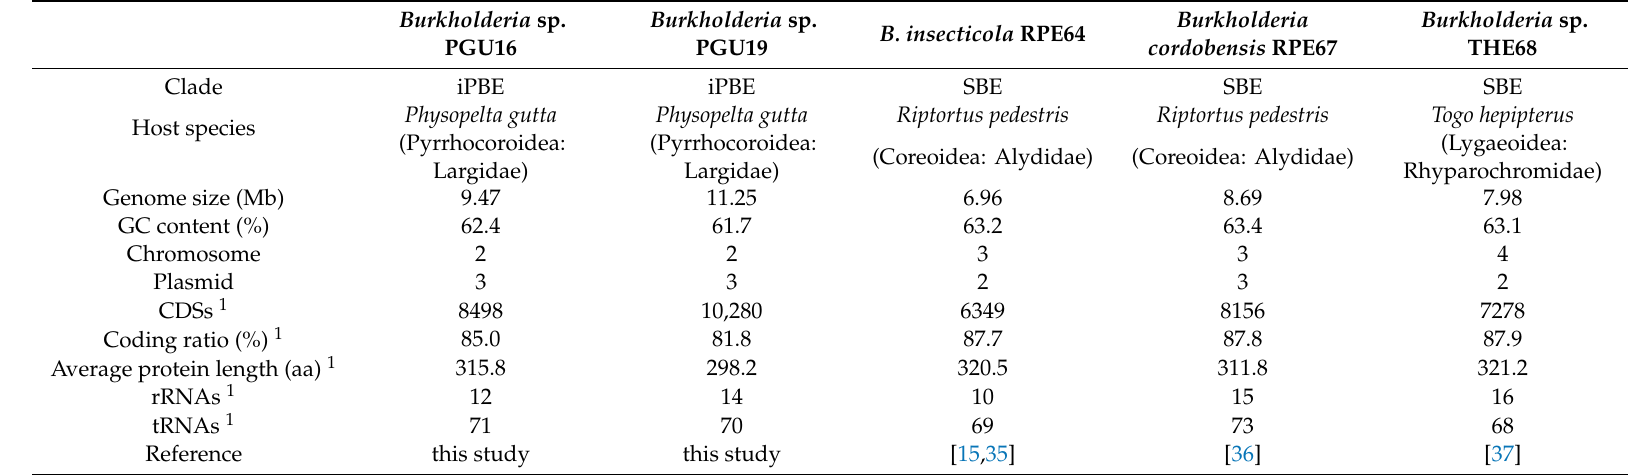
Table 2. Statistics of the complete genomes of Burkholderia symbionts of stink